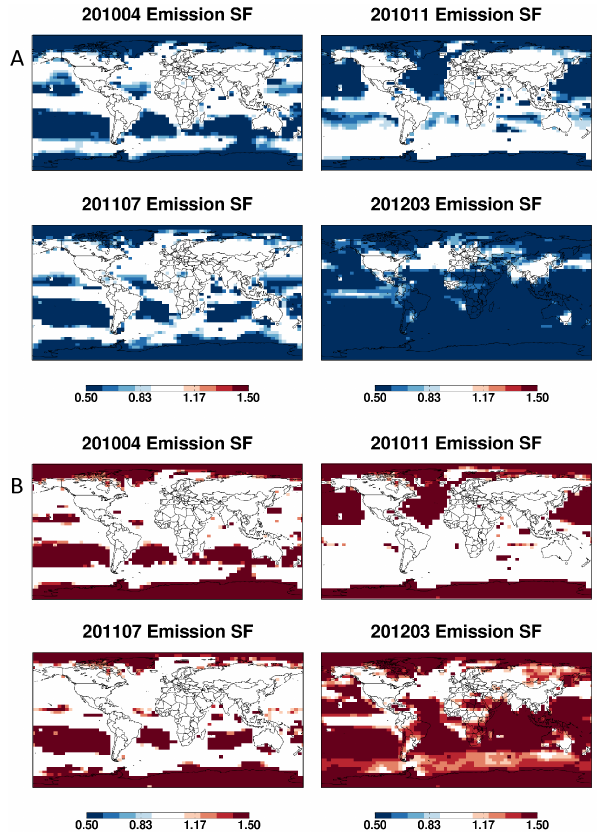
Figure 4. Pseudo observation tests optimizing N 2 O emissions on the basis of surface observations. Shown are a posteriori emission scaling factors using an a priori guess of either (a) 0.5 or (b) 1.5, where the true value is 1.0. Results are shown for April 2010 (month 1 of the inversion window), November 2010 (month 8), July 2011 (month 16), and March 2012 (month